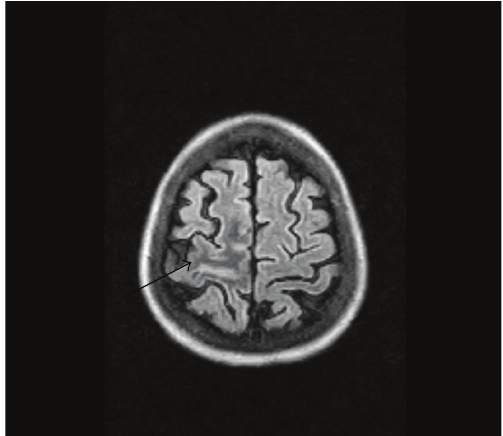
Figure 3: Axial T2 FLAIR image shows subcortical T2 hypointen- sity in right pre- and postcentral white matter.